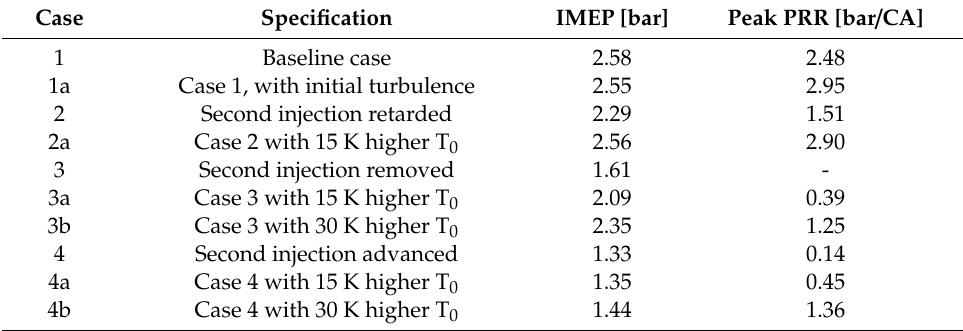
Table 2. Indicated mean e ff ective pressure (IMEP) and Peak pressure-rise rate (PRR) of the studied cases. T 0 is the temperature of the in-cylinder charge at 25 CAD